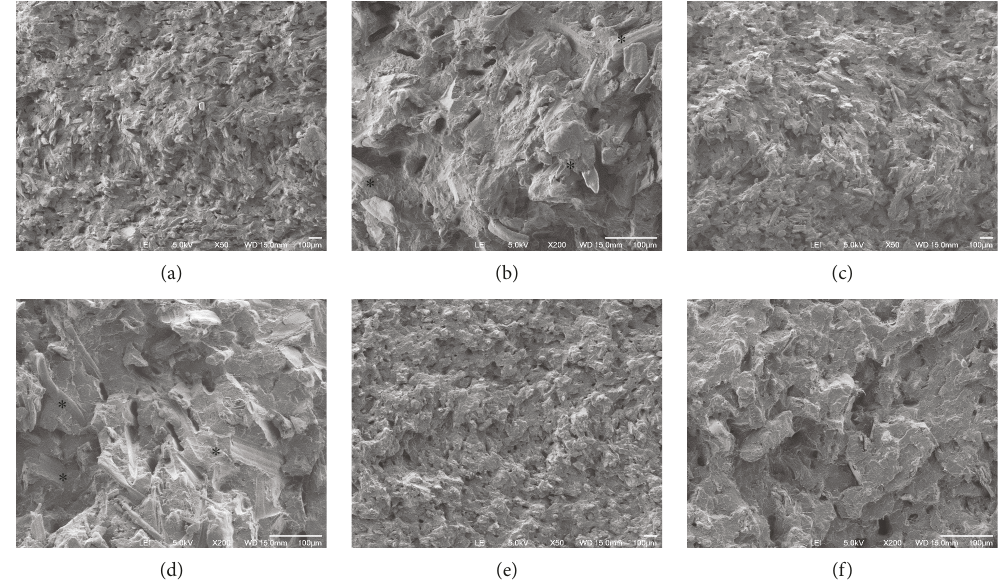
Figure 8: Scanning electron microscopy images of fracture surfaces; e ff ect of chain extender additives on fi bre pull-out. (a, b) Plain PLA containing 30wt % of MDF fi bre. (c, d) PLA containing 30wt % of MDF fi bre and 3wt % BioAdimide®. (e, f) PLA containing 30wt % of MDF fi bre and 1wt % Joncryl®. Asterisks indicate a fi bre pull-out. Scale bar =100 μ m ( n = 1